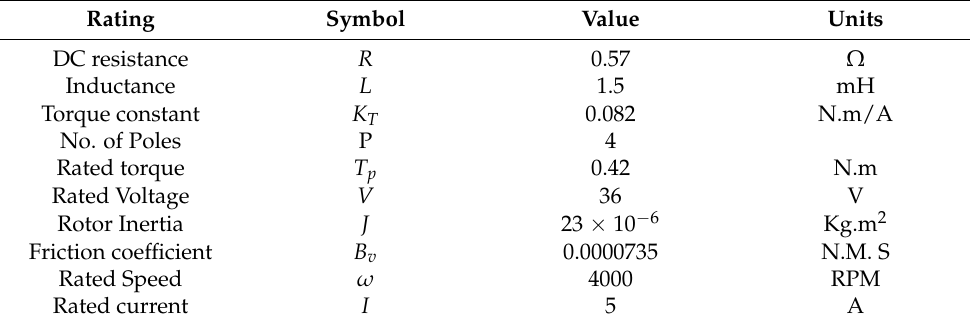
Table 1. The BLDC motor parameters.